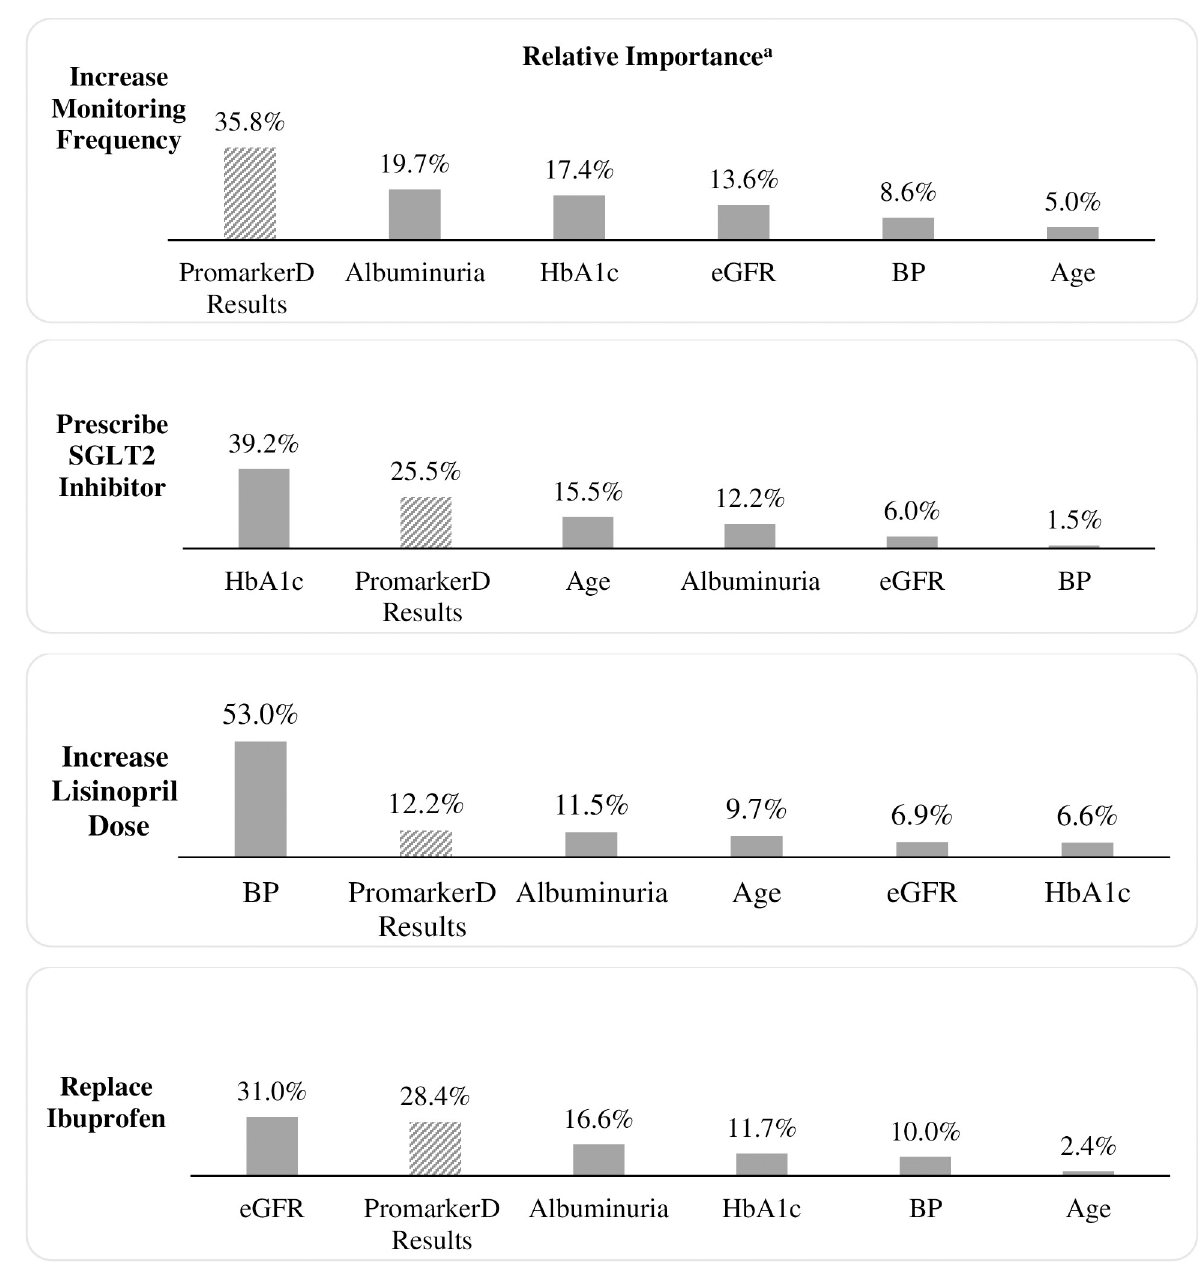
Fig 4. The relative importance of each attribute in influencing measured